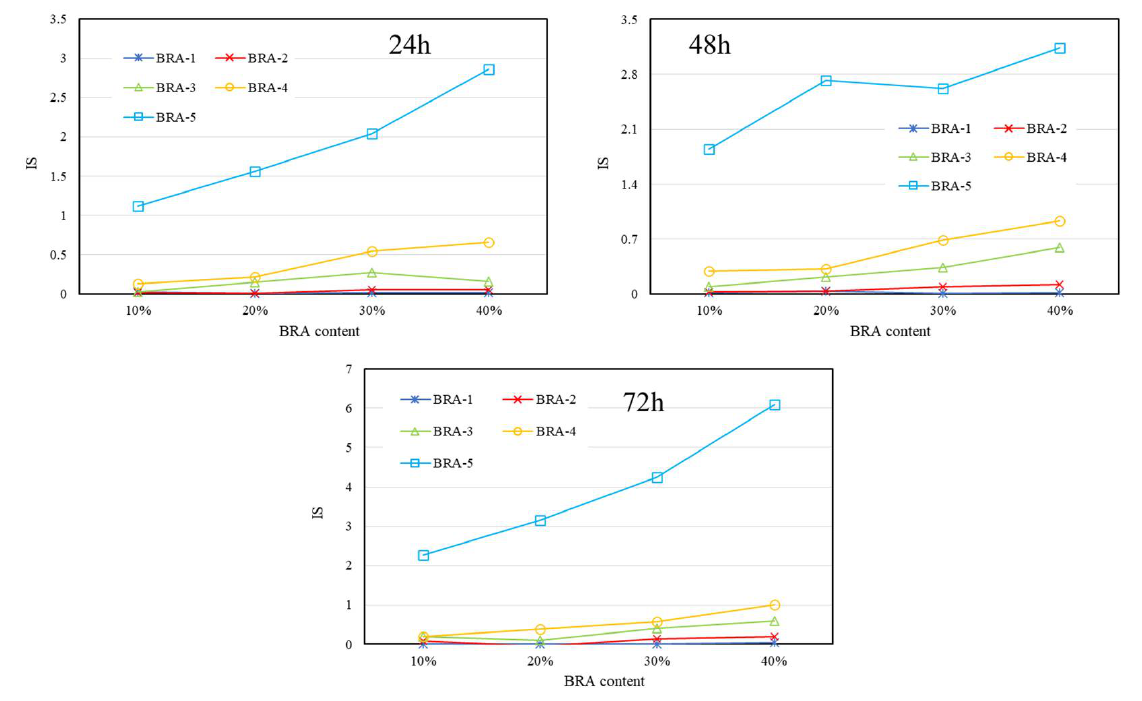
Figure 19. IS of BRA-MA after the segregation process at 165 °C.